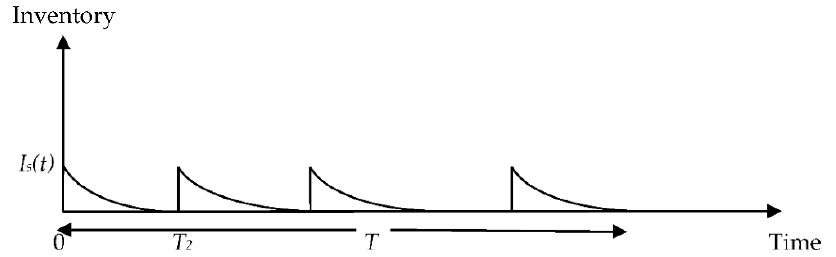
Figure 2. The behavior of the supplier’s inventory level versus time. 0 the inventory level decreases due to the de- During the time interval, 2 mand and deterioration rate. Hence, the variation in the level of inventory versus time t is given below: